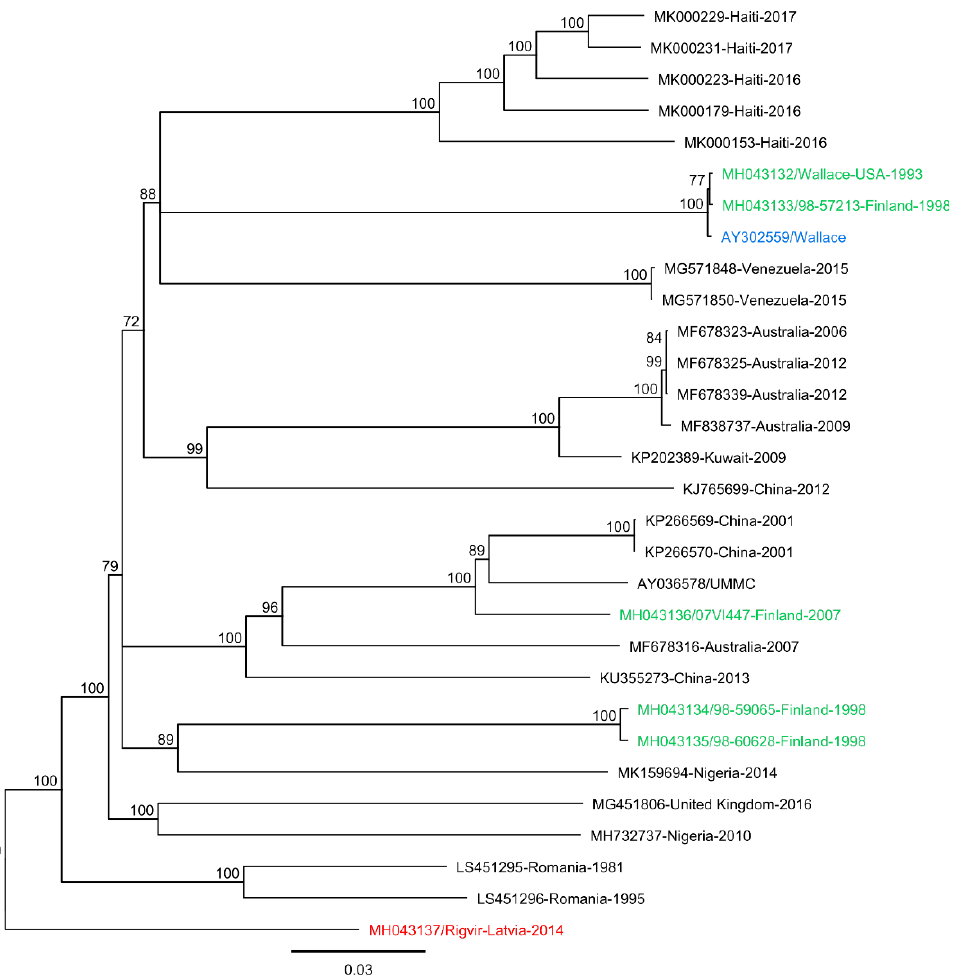
Figure 1. Neighbor-joining consensus tree of Rigvir ® and other full-length echovirus 7 (E7) sequences obtained from GenBank using 500 bootstrap replicates, with bootstrap values of ≥ 70% shown. Clinical isolates from this study are colored in green, Rigvir ® in red, and the prototype Wallace sequence in blue.